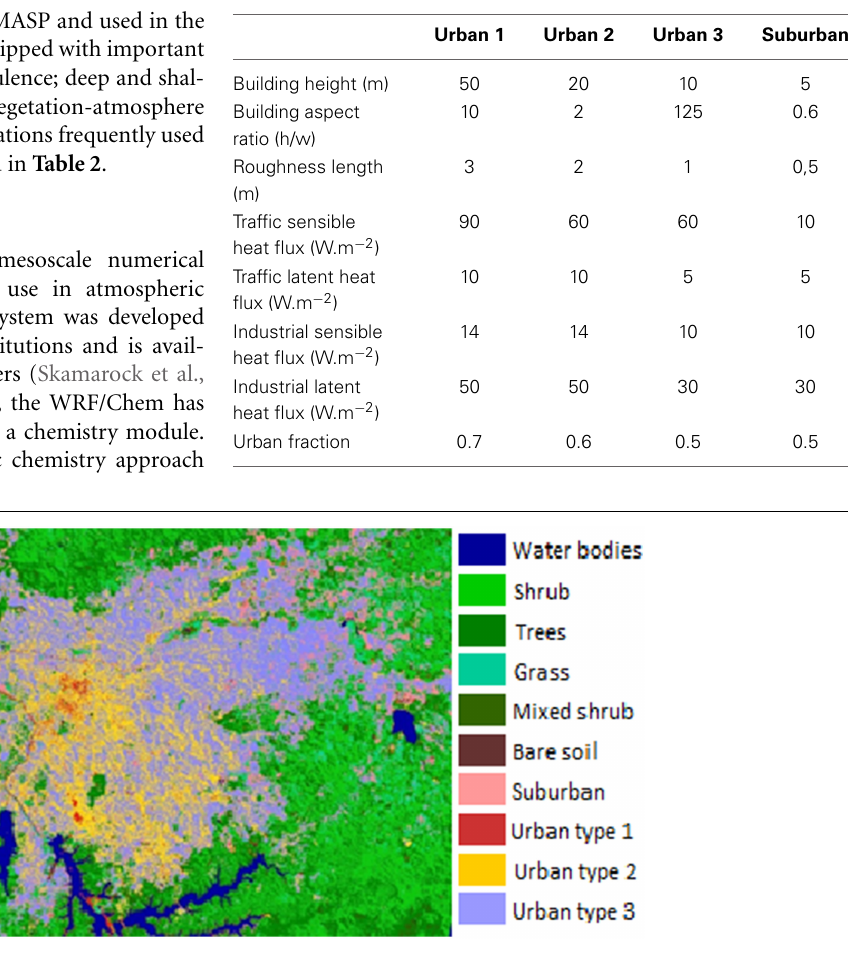
Table 1 | Some values of Town Energy Budget parameters used in the BRAMS-SPM model to differentiate characteristics based on the urban canyon concept.